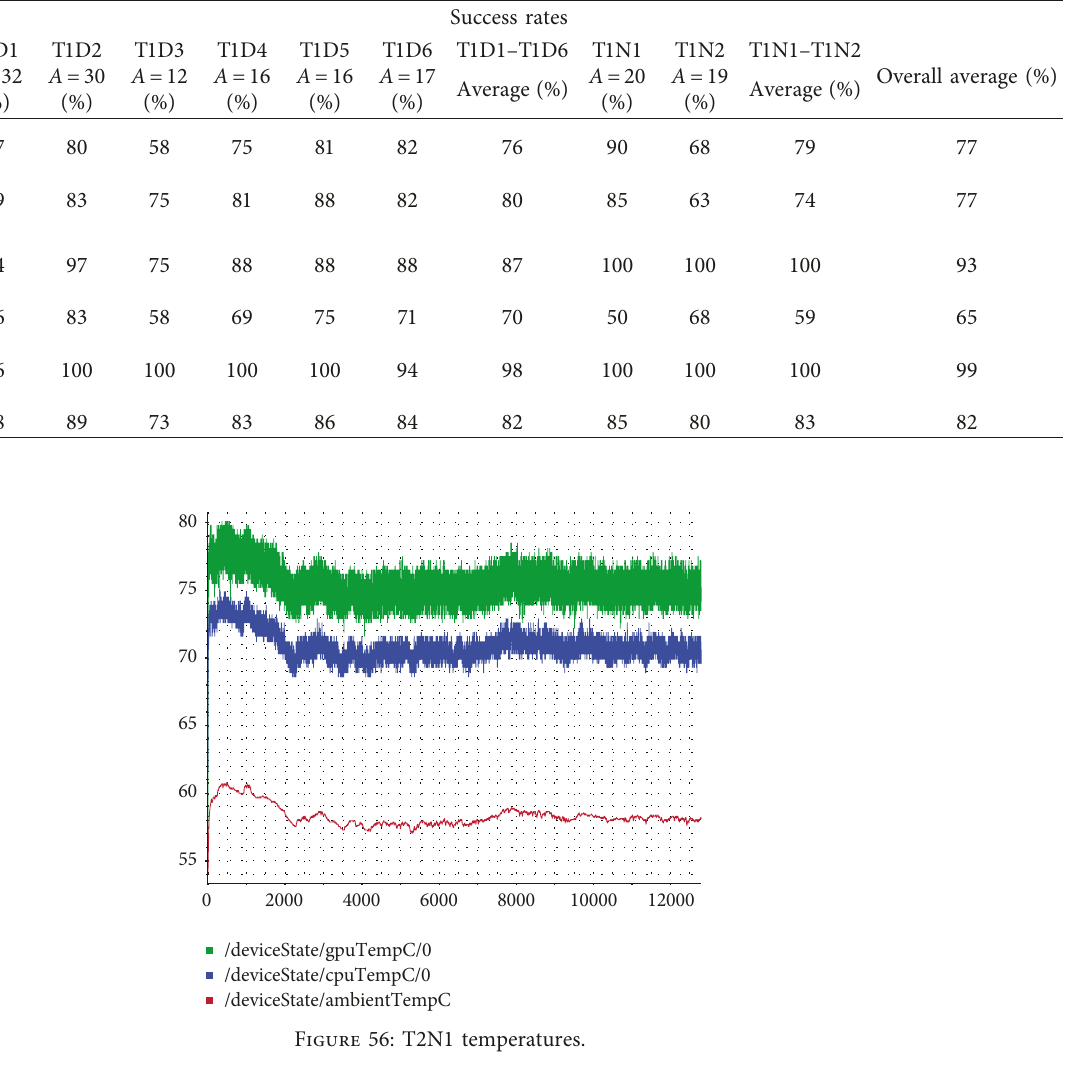
Table 6: Analysis of all drives in